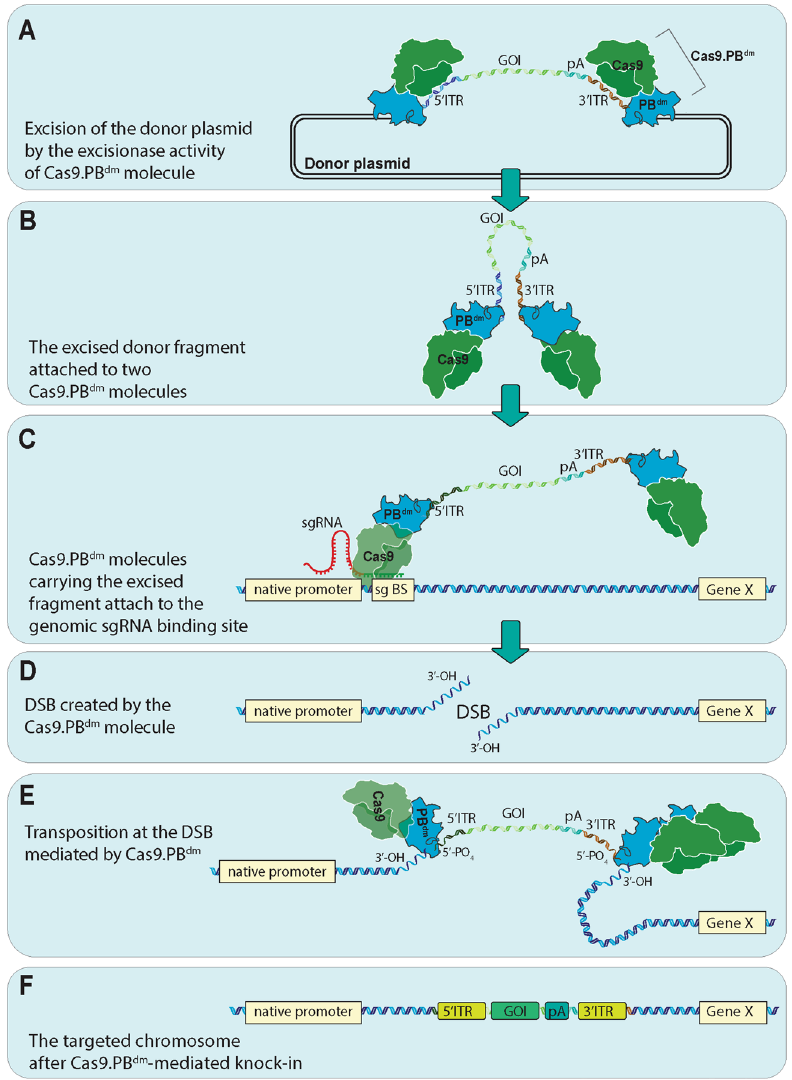
Figure 6. Schematic illustration of TransCRISTI mediated gene knock-in method. The TransCRISTI effector (Cas9.PB dm ) is composed of a Cas9 endonuclease and an integrase-deficient piggyBac transposase which are fused by a peptide linker. The TransCRISTI donor is a PB transposon plasmid carrying a gene of interest (GOI) flanked by the piggyBac transposon ITRs. GOI can be a reporter gene (with or without promoter), a selectable marker gene, and a coding sequence for a therapeutic gene. This figure shows one example of the use of the TransCRISTI method for the insertion of a promoterless GOI in a genomic region and its expression under the control of the endogenous (genomic) promoter. ( A ) The excisionase function of TransCRISTI effector molecule. The transposon cassette is excised at the vicinity of the left and right ITRs by the activity of two distinct effector molecules. ( B ) The transposon fragment after excision is attached to a Cas9.PB dm molecule at each end in a U-shaped structure. ( C ) The RNA guiding and nuclease function of the TransCRISTI effector molecule. The Cas9.PB dm molecule is guided by the attachment of complementary sgRNA to a specific sgRNA binding site in the genome. ( D ) A double-strand DNA break (DSB) is created at the guided site by the nuclease activity of Cas9 moiety in Cas9.PB dm . ( E ) The available transposon in the vicinity (tethered by the PB dm moiety) will be used for integration in the break site as a repair patch. ( F ) The GOI after this site-specific insertion can be expressed by the activity of the endogenous